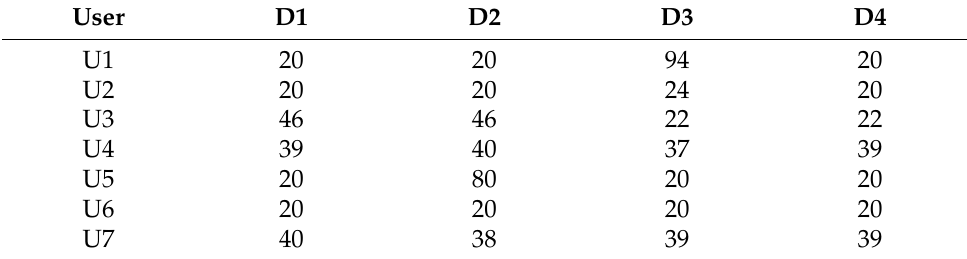
Table 2. Number of recordings of good quality selected for the analysis per each user and each